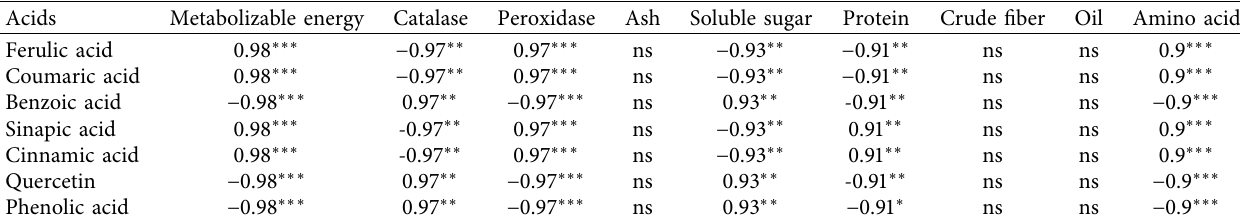
Table 4: Correlation matrix of fruit phenolics with nutritive parameters of M. charantia .